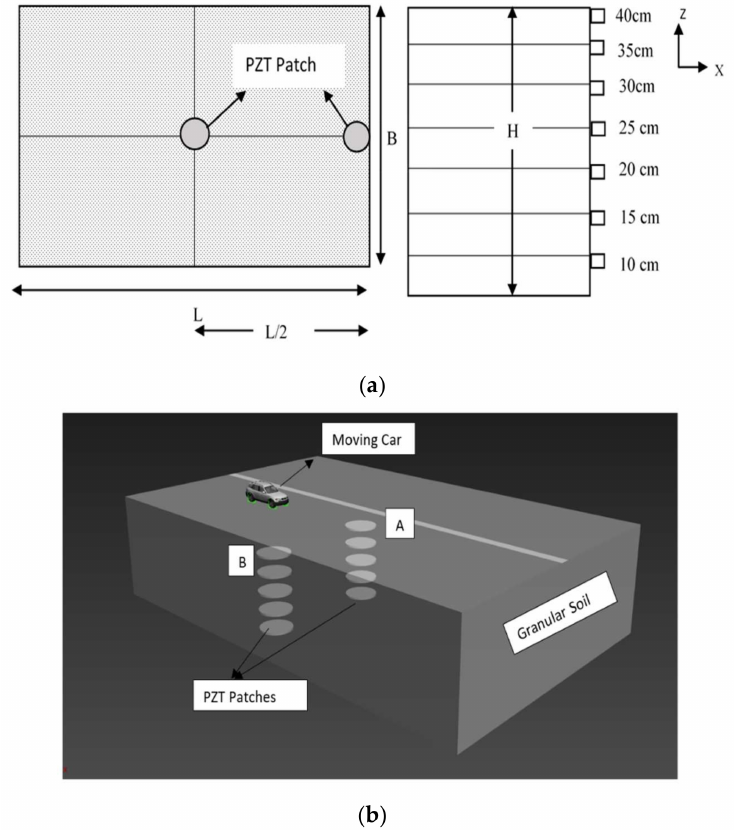
Figure 3. ( a ) Layout of the PZT patch embedded into the confined granular fill for the vertical and transverse vibrations; ( b ) The optical image of the embedded PZT patches in pavement at various